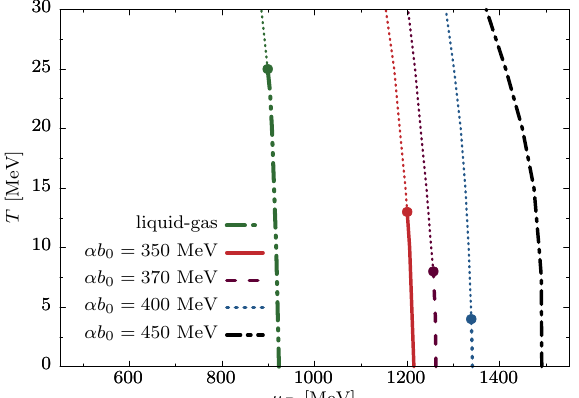
Figure 7. Low-temperature part of the phase diagram in the ( T , µ B ) -plane for isospin-symmetric matter obtained in the hybrid model. The green dashed-doubly-dotted curve corresponds to the liquid–gas phase transition common for all α b 0 . The circles indicate critical points on the transition lines above which the first-order transition turns into a crossover. No critical point is shown for the case with α b 0 = 450 MeV, for which the chiral transition is a smooth crossover at all